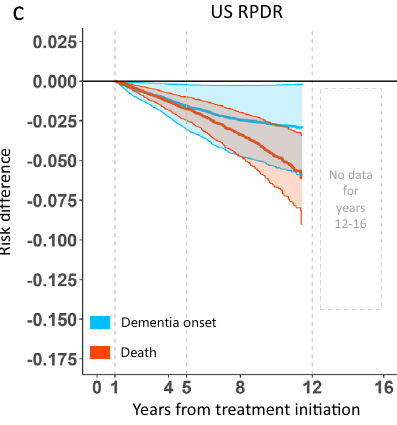
death (in orange hues) for metformin vs. sulfonylurea initiators. Follow-up times are up to 12 and 16 years in the US RPDR ( a ) and the UK CPRD ( b ) cohorts, respectively. c , d Riskdifferencecurvesfordementiaonset(inblue)andcompeting death (in orange),inthe USRPDR( c ) and the UK CPRD( d ) cohorts, respectively. A negativeriskdifferencevalueduringcertaintimeperiodsindicatesthatinitiationof metformin is bene fi cial, as compared to